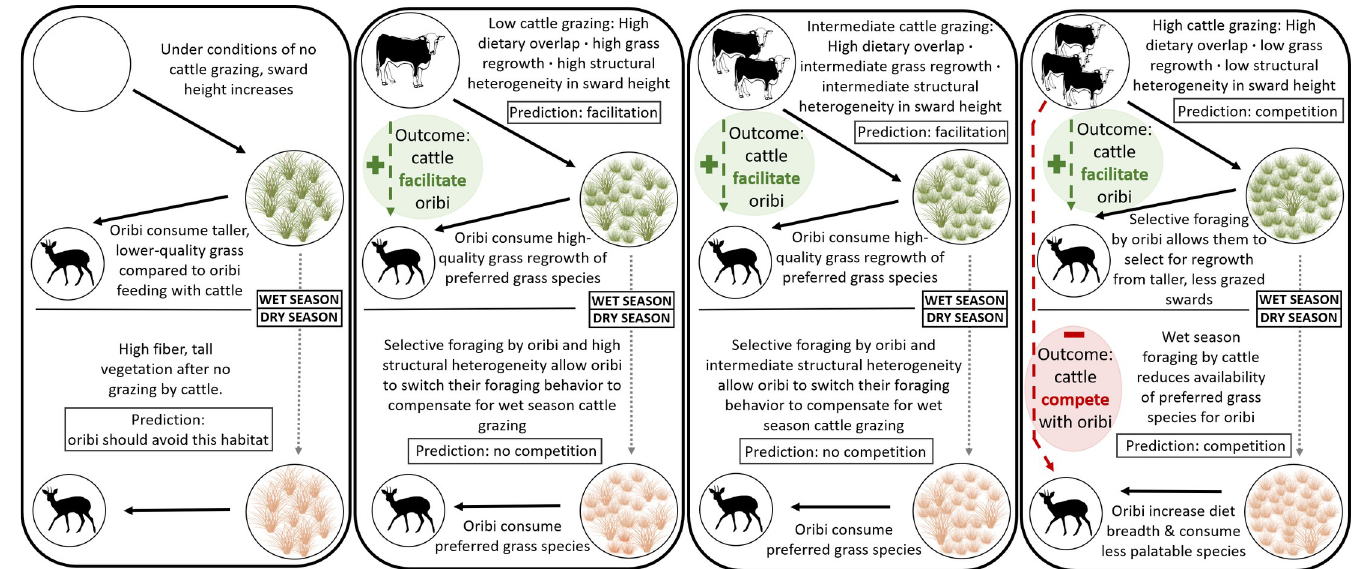
Fig 1. Graphical representation of our experimental design. We leveraged different cattle stocking rates across two seasons (wet and dry) to identify potential drivers of interspecific interactions between oribi antelope and cattle. Cattle grazing under different intensities can alter the structural heterogeneity of grass swards as well as alter the availability of specific grass species. In turn, these changes can influence oribi foraging behavior and ultimately, influence their nutritional intake rates, which can lead to either competitive or facilitative interactions between cattle and oribi. Cattle and oribi only directly overlap during the wet season. As a result, interspecific interactions that are observed during the dry season as a consequence of the intensity of cattle grazing in the previous wet season.